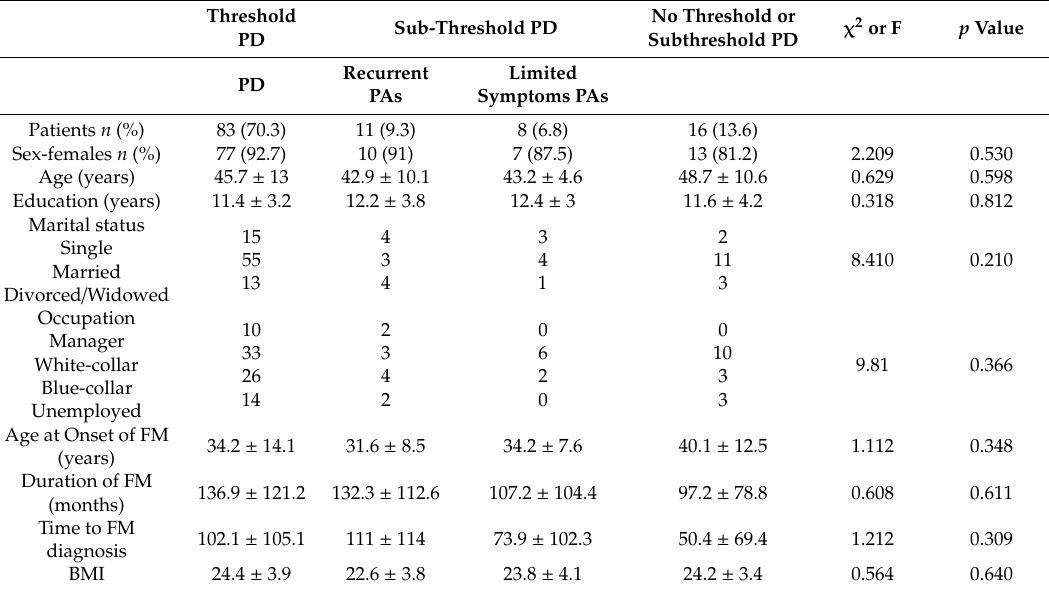
Table 3. Panic disorder (PD) and subthreshold panic, demographic, and clinical characteristics.